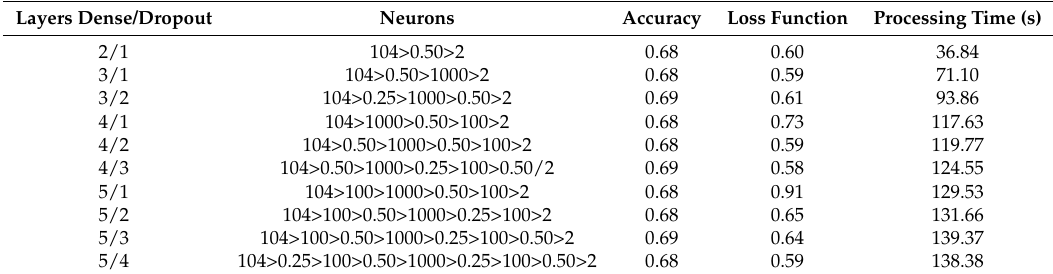
Table 2. Comparison of the accuracy and loss function values obtained using different number of layers and neurons.